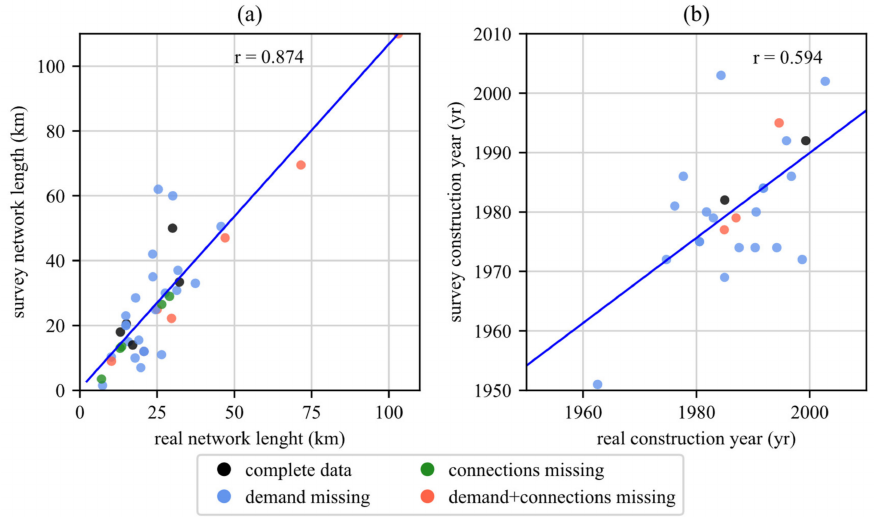
Figure 5. Correlation of ( a ) real network length from the pipe information system and estimated network length form the survey and ( b ) real construction year from the pipe information system and estimated construction year from the